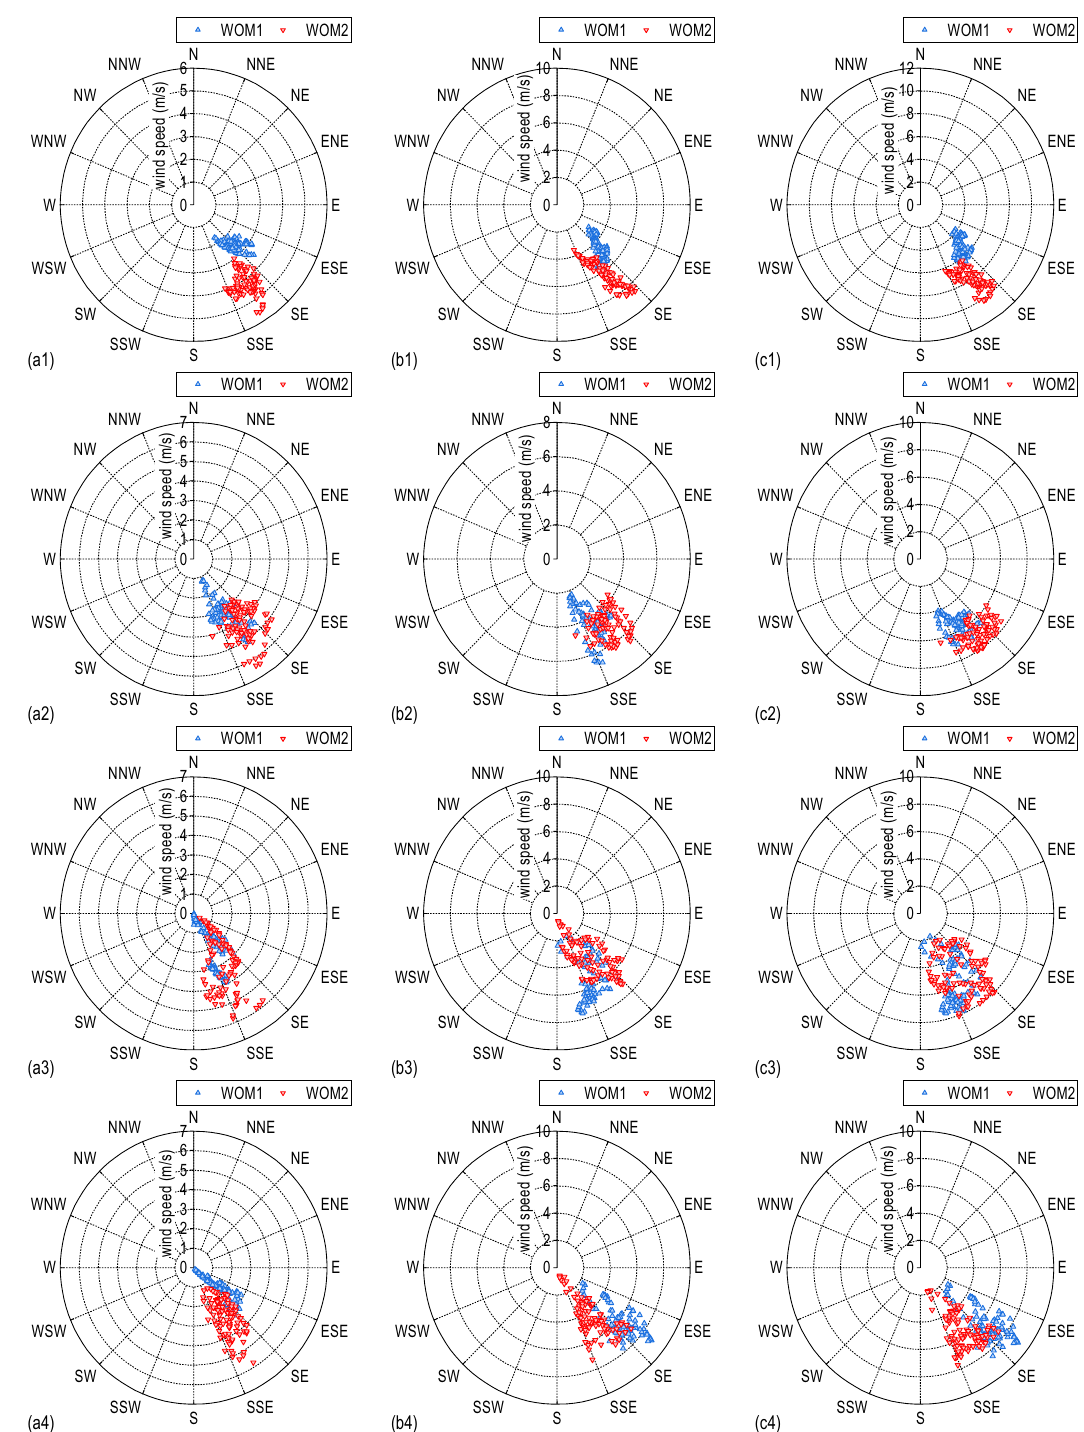
Figure 5. Wind rose of wind direction and: ( a ) lateral bridge wind speed, ( b ) longitudinal bridge wind speed, ( c ) total wind speed; (1) Lane 1, (2) Lane 2, (3) Lane 3, (4) Lane